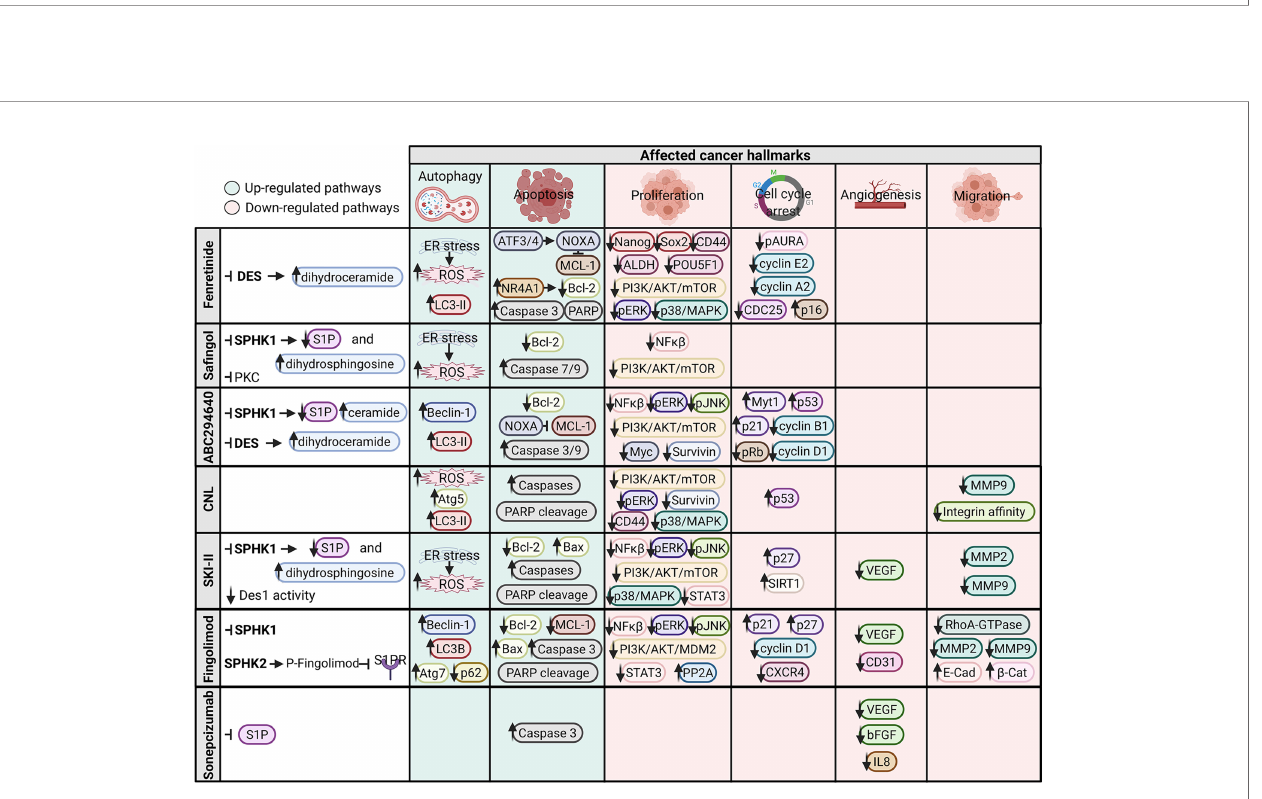
Frontiers in Oncology |